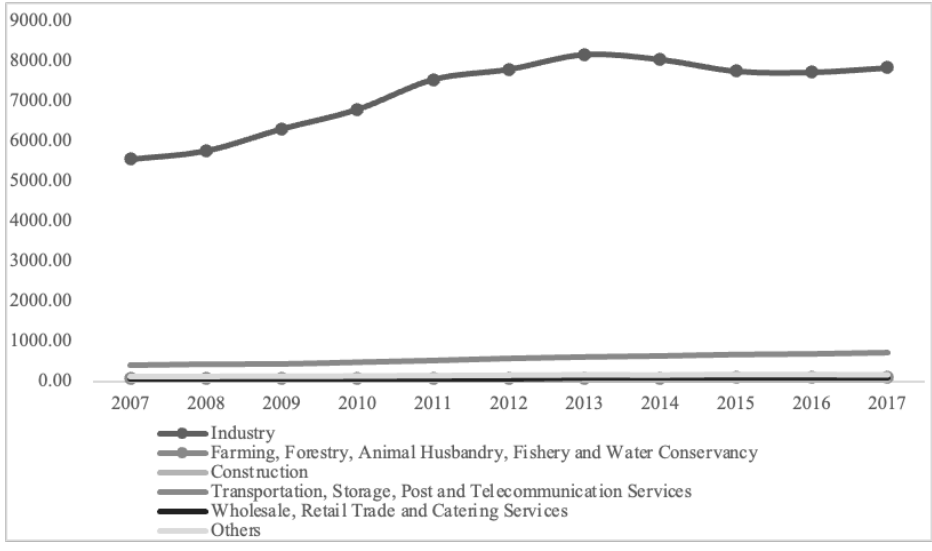
Figure 5. CO2 emissions by sector (2007 – 2017). Figure 5. CO 2 emissions by sector (2007–2017).